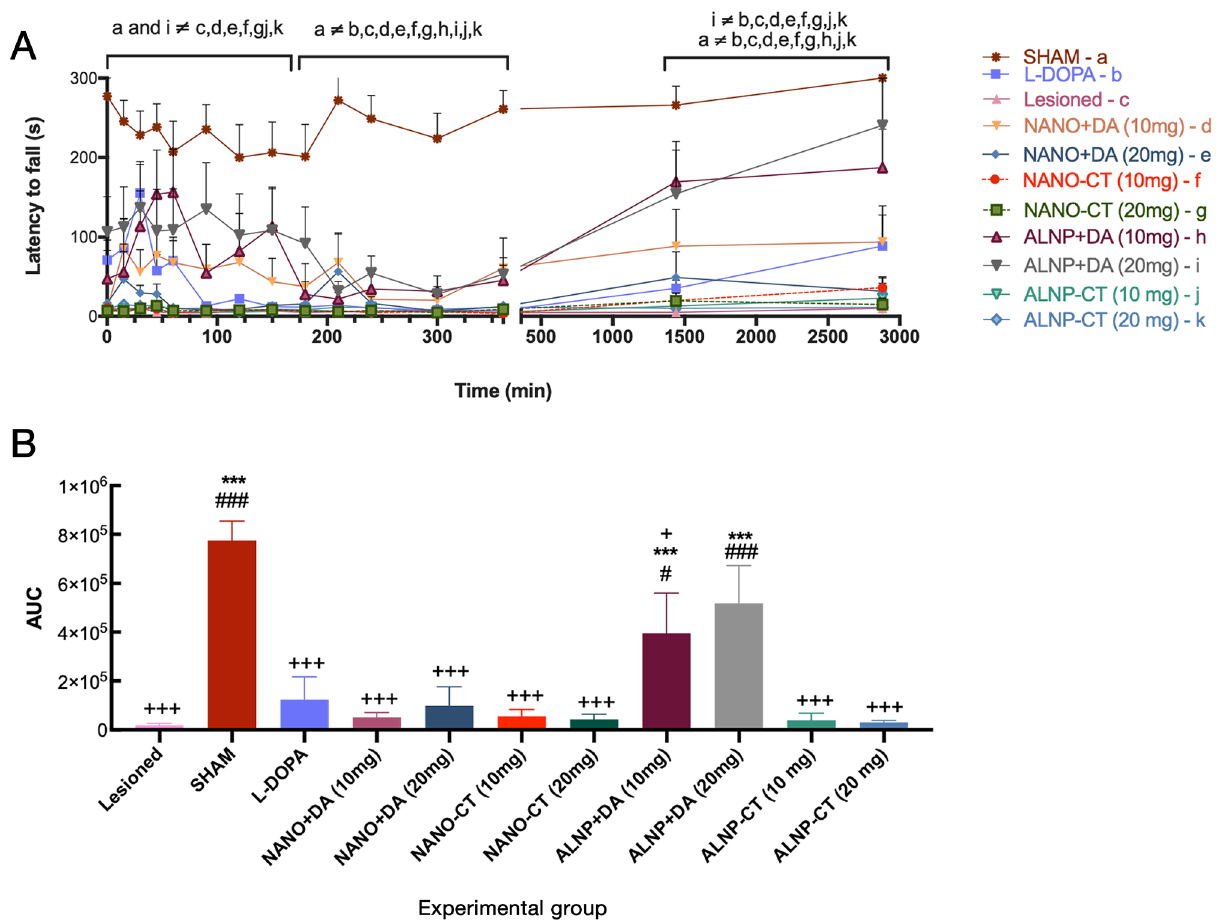
Figure 6. ( A ) Latency to fall ( s ) from the rotarod in Sham and 6-OHDA-lesioned mice treated either with bulk L-DOPA, NANO-Control (NANO-CT; 10 or 20 mg/animal; NANO + Dopamine (NANO-DA; 10 or 20 mg/ animal); dopamine-loaded-albumin/PLGA nanosystems (ALNP + DA; 10 or 20 mg/animal); and unloaded albumin/PLGA nanosystems (ALNP-CT; 10 and 20 mg/animal). Data were submitted to ANOVA multivariate analysis, followed by the Bonferroni post-test. Letters indicate statistically significant difference ( p < 0.001). (a) Sham, (b) L-DOPA, (c) Lesioned, (d) NANO + DA 10 mg, (e) NANO + DA 20 mg, (f) NANO-CT 10 mg, (g) NANO-CT 20 mg, (h) ALNP + DA 10 mg, (i) ALNP + DA 20 mg, (j) ALNP-CT 10 mg, (k) ALNP-CT 20 mg. N = 7 animals/group. ( B ) Area under the curve (AUC) analysis for the latency to fall test in Sham and